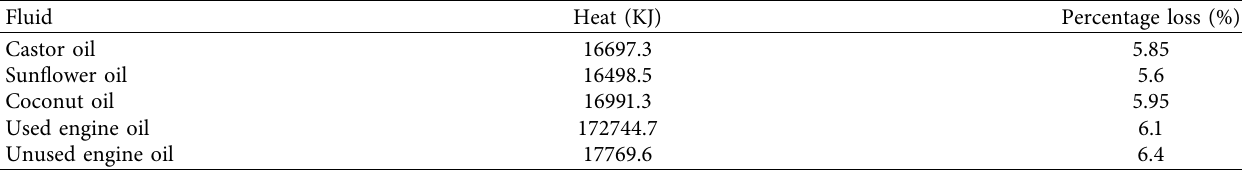
Table 2: Percentage heat losses for the oil-based copper nano-heat transfer fluids.